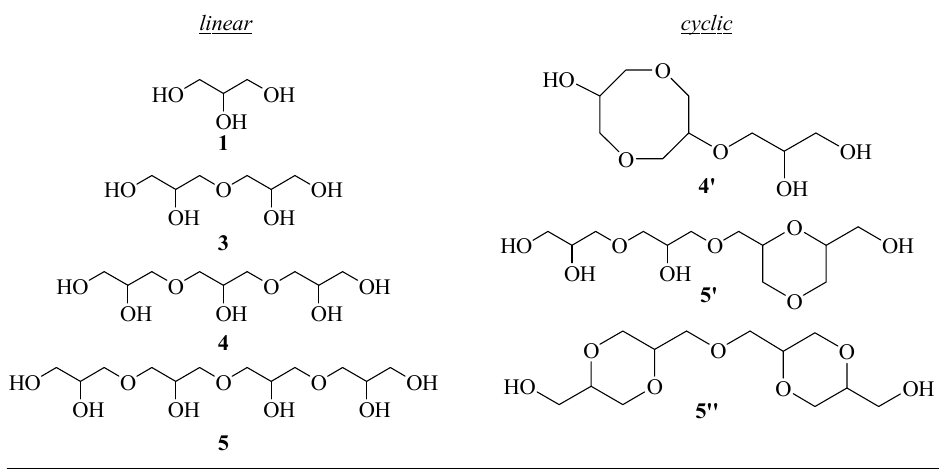
Scheme 1. Linear and cyclic oligomers obtained during glycerol etherification with (2).